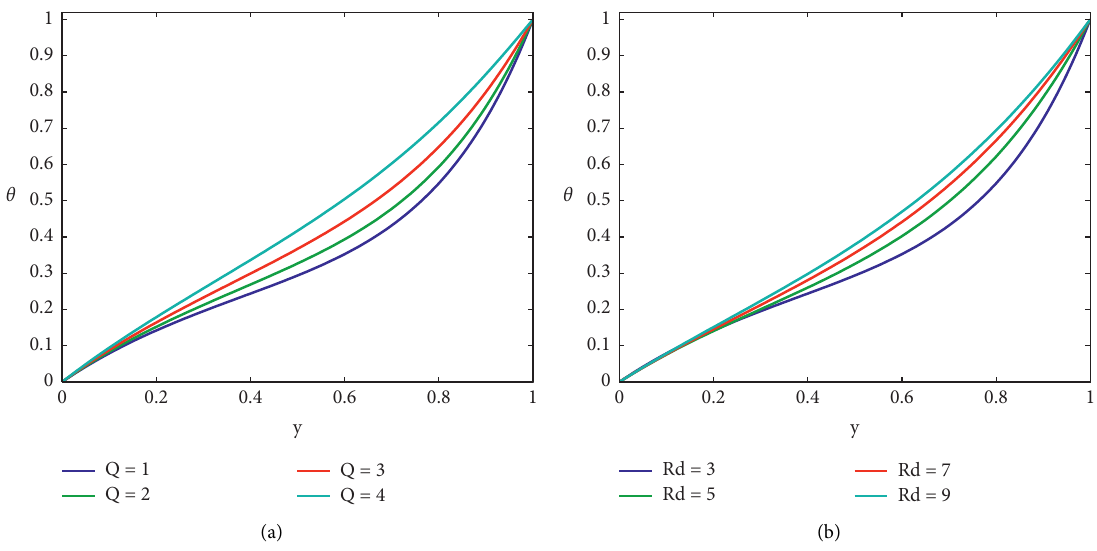
Figure 7: (a) Effect of Q on the “temperature distribution” when Rd � 3. (b) Effect of Rd on the “temperature distribution” when Q � 0 .